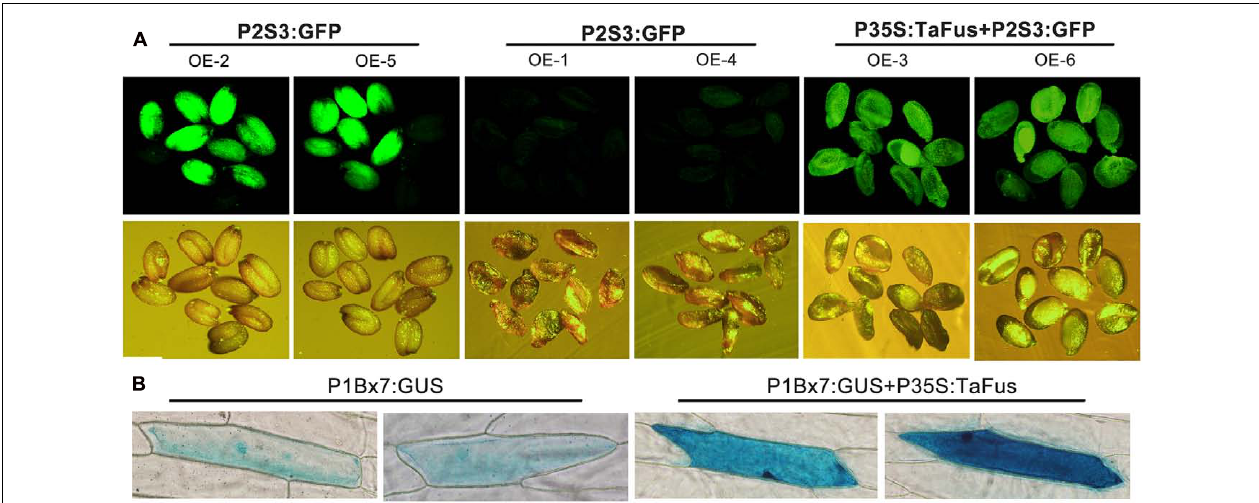
FIGURE 9 | Complementation of TaFUSCA3 in the A. thaliana FUSCA3 mutant line fus3-3 and transcriptional regulation of the promoter of Ta1Bx7 in a transient expression system. (A) The GFP gene under the control of the At2S3 promoter and the TaFUSCA3 gene driven by the CaMV 35S promoter were transformed into wild-type and fus3-3 lines of A. thaliana , respectively. The genetic background of OE-2 and OE-5 was wild-type; that of OE-1, OE-4, OE-3, and OE-6 was the FUSCA3 mutant line fus3-3. The seeds of transgenic lines were observed under a fluorescence microscope to evaluate the expression level of the At2S3 promoter. (B) The GUS gene under the control of the Ta1Bx7 promoter and the TaFUSCA3 gene driven by the CaMV 35S promoter, respectively, were transformed into onion epidermal cells in a transient expression system.